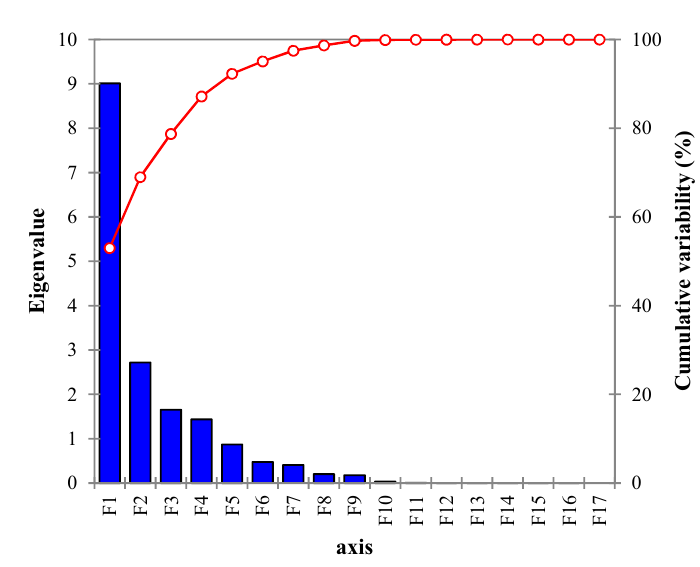
Figure 3. Scree plot of principal